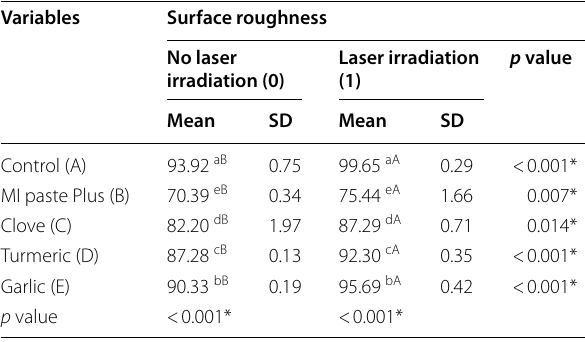
Means with different small letters in the same column indicate significant difference, means with different capital letters in the same row indicate significant difference *; significant ( p <